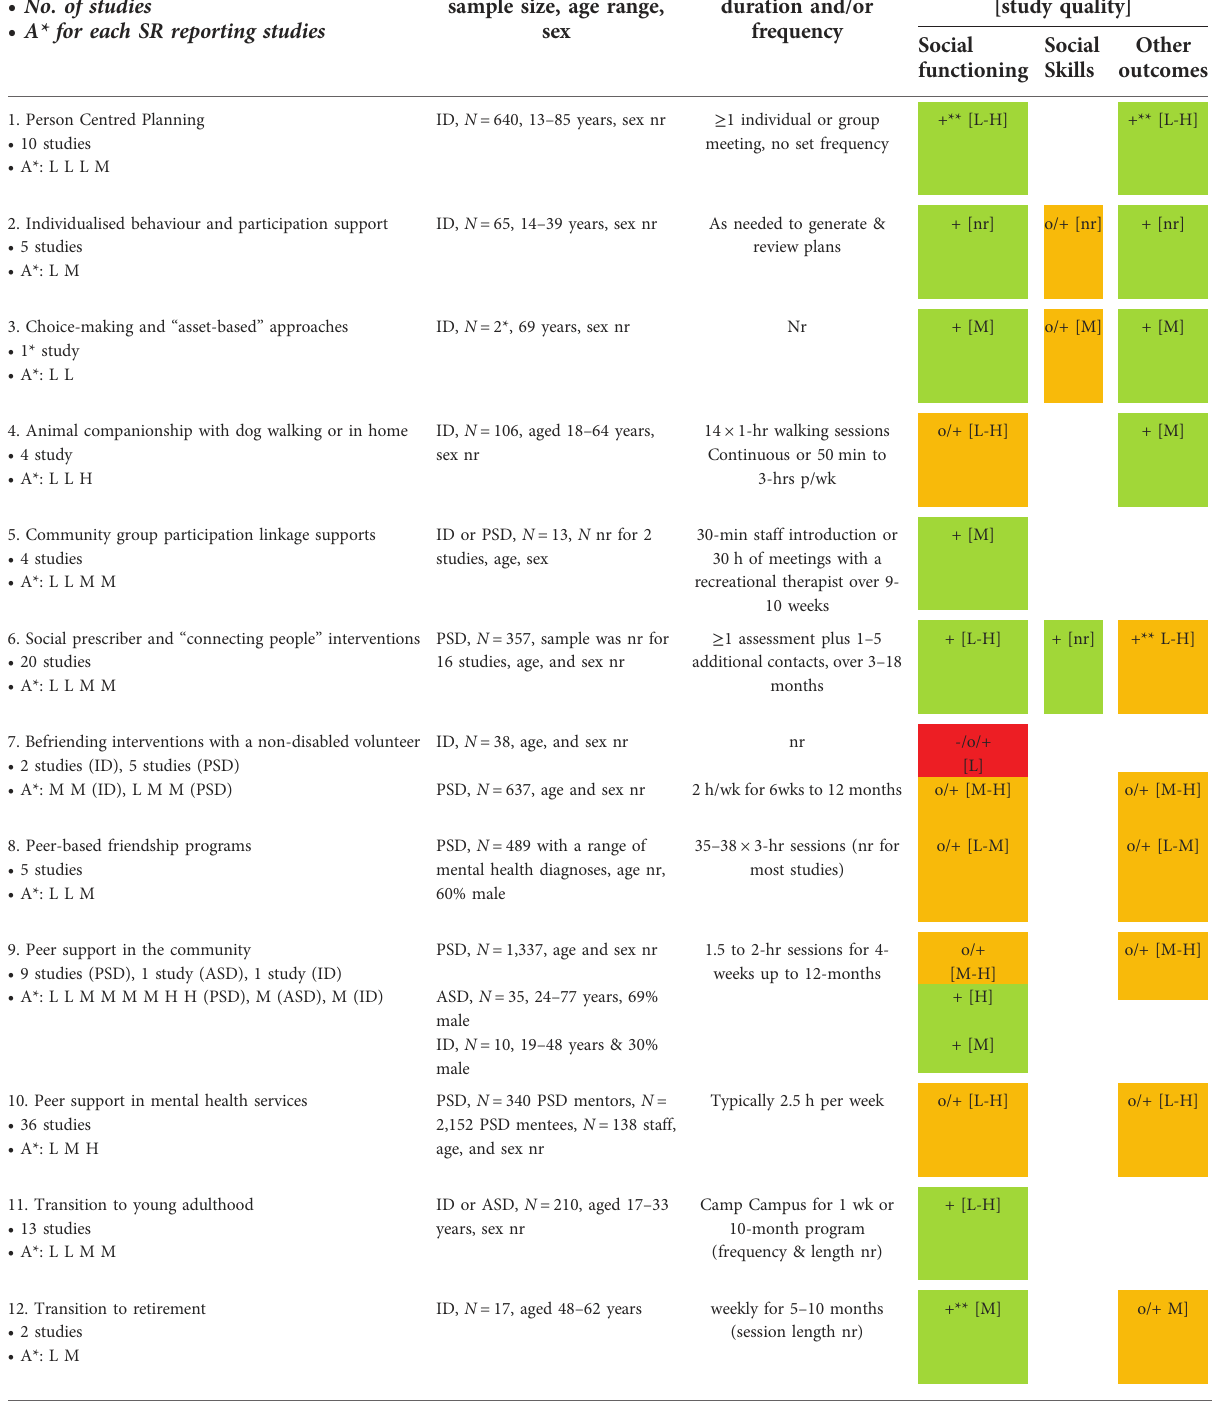
TABLE 2 Overall effects of intervention processes and supports to help people connect with social, community or civic participation opportunities, including AMSTAR quality rating of the SRs and quality of the original studies. Intervention (cid:129) No. of